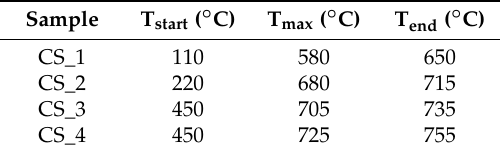
Table 2. Thermal decomposition parameters of carbon spheres with different times of synthesis from differential thermogravimetry (DTG) curves in Figure